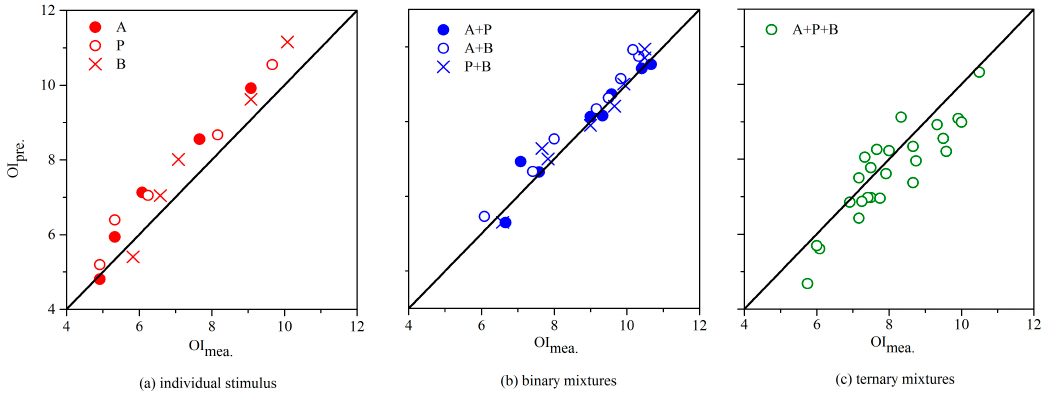
Figure 6. The comparison between measured OI (OI mea. ) and predicted OI (OI pre. ) of individual aldehydes (acetaldehyde, A; propionaldehyde, P; n -butyraldehyde, B), and their binary mixtures, ternary mixture. The solid line means completely match.